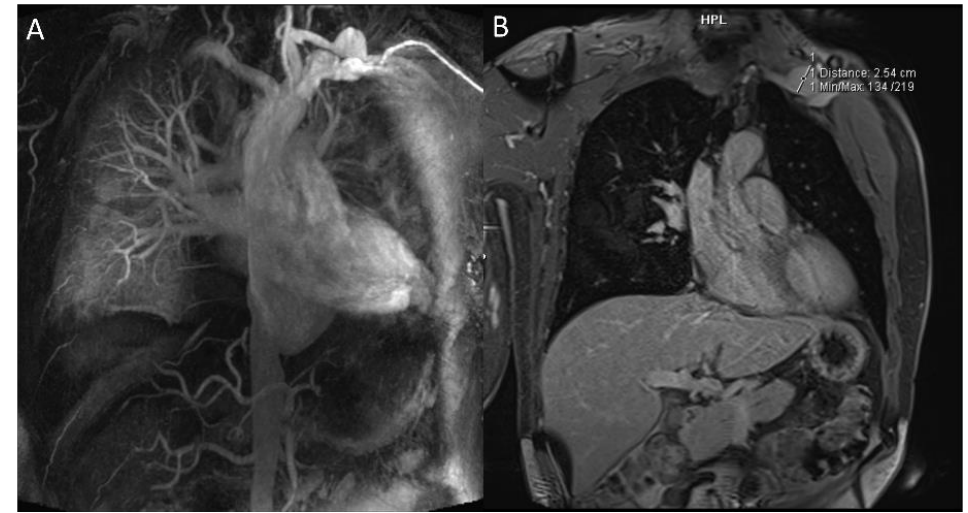
Figure 2. ( A , B ) Angio-MRI MIP reconstructions in BD patient that show aneurysm of left subclavian artery.